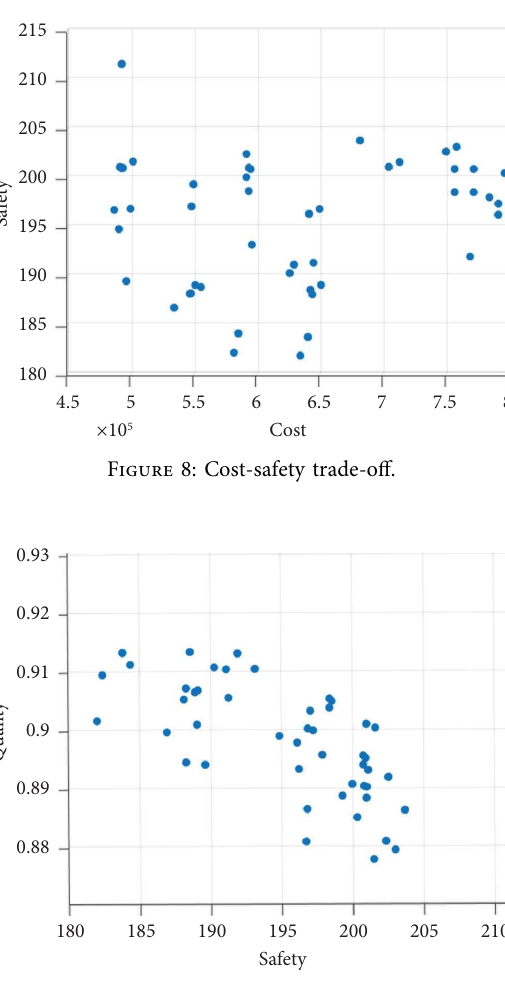
Figure 9: Quality-safety trade-of.